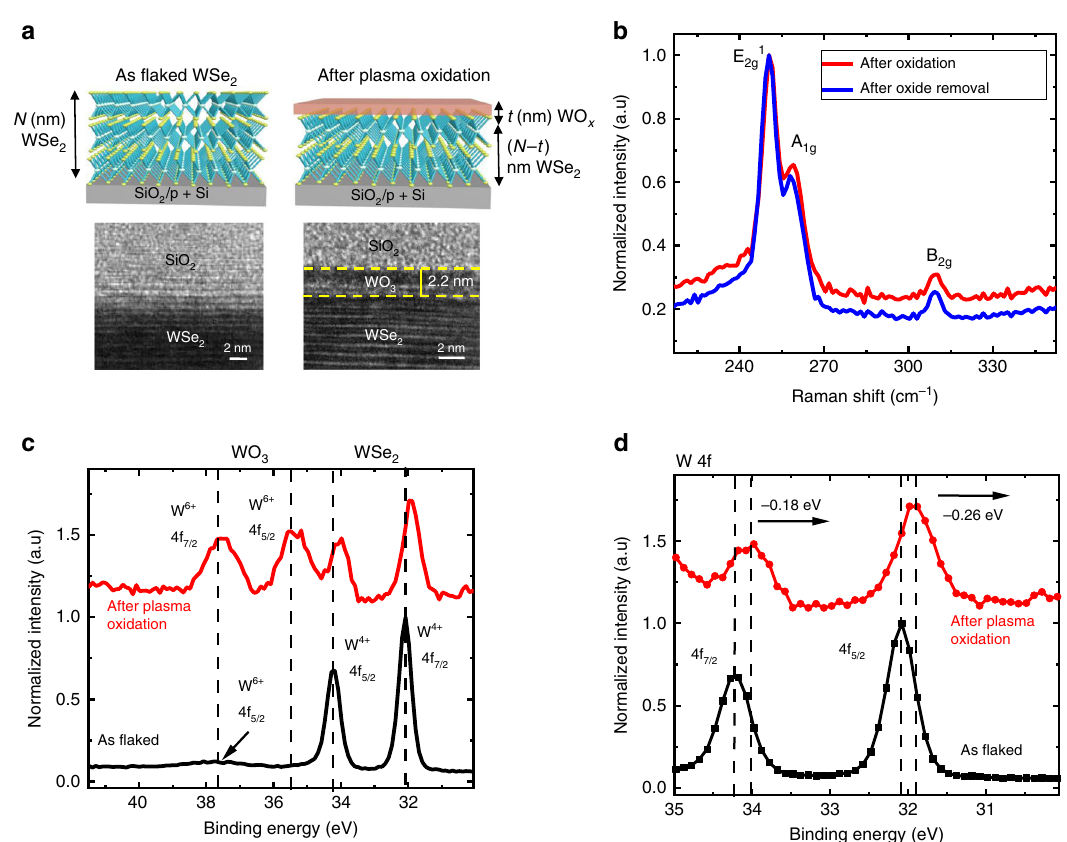
Fig. 1 Remote plasma oxidation process and characterization. a Schematic representation of surface plasma oxidation and the corresponding cross- sectional transmission electron microscope (xTEM) images. The xTEM image of oxidized WSe 2 shows 2.2 nm of WO 3 upon oxidation, which is a consumption of three layers of WSe 2 . b Raman spectroscopy comparison before oxidation and after oxide removal, in order to have comparison between WSe 2 of same thickness. No apparent change in peak position is observed, implying no crystalline damage due to plasma oxidation. c X-ray photoelectron spectroscopy (XPS) comparison of as fl aked WSe 2 and plasma-oxidized WSe 2 . The appearance of two additional peaks after oxidation corresponds to an x factor of 3 in WO x . d W 4f core level XPS spectrum comparison of pristine WSe 2 and plasma-oxidized WSe 2 . The observed shift to lower binding energy implies electron transfer from WSe 2 to WO